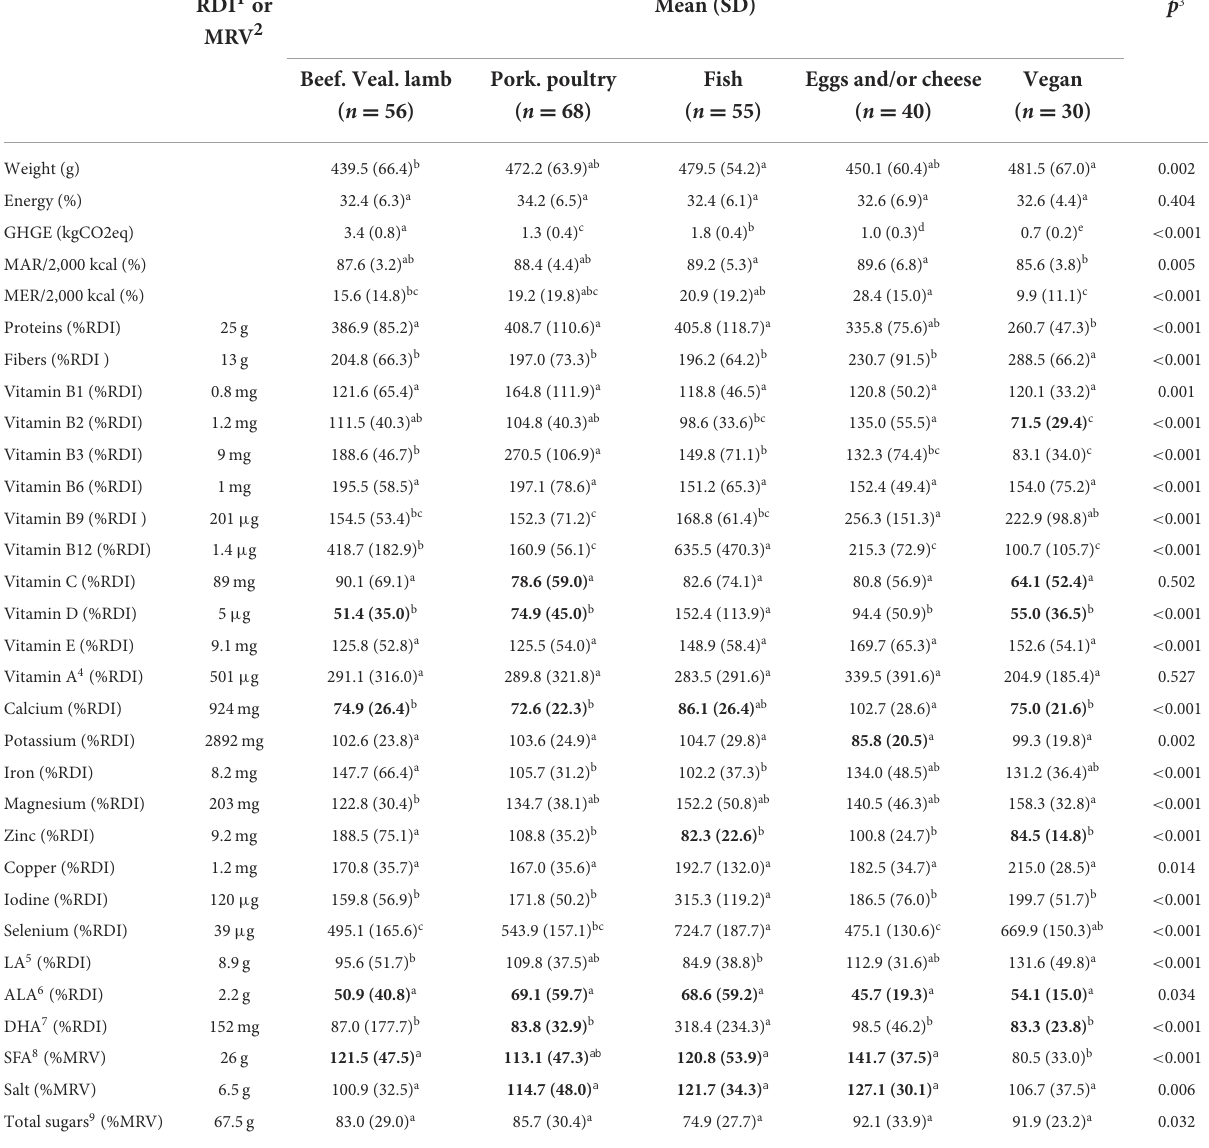
TABLE 3 Nutritional quality and environmental impact across the five meal subcategories based on protein dish: beef, veal, lamb ( n = 56); pork and poultry ( n = 68); fish ( n = 55); eggs and/or cheese ( n = 40); vegan ( n = 30) served in the Dijon school canteens in 2019. RDI 1 or Mean (SD) p 3 MRV 2 Beef. Veal.